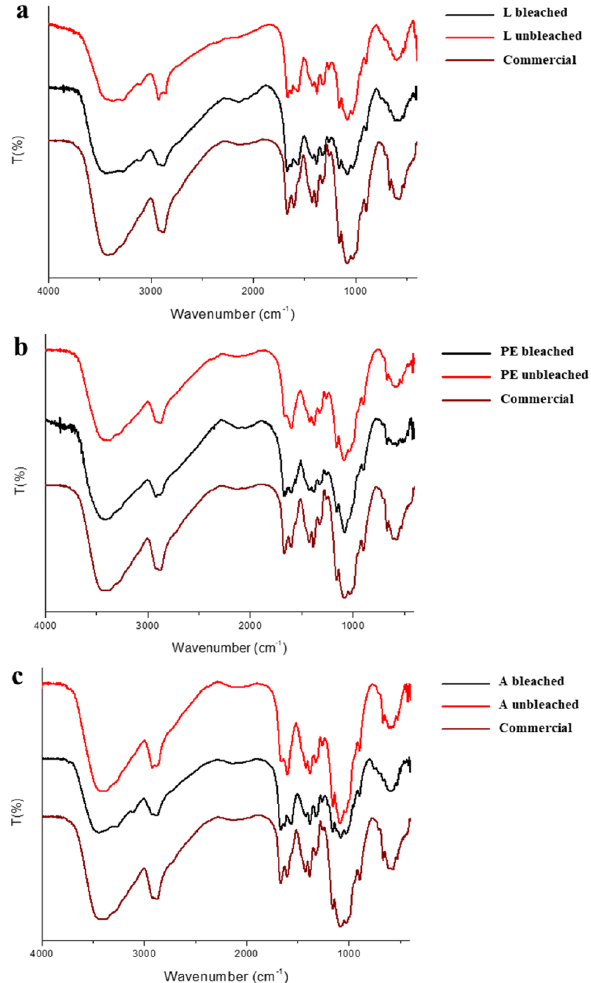
Figure 2. FTIR spectra of bleached (black line) and unbleached (red line) chitosan samples extracted from H. illucens larvae ( a ), pupal exuviae ( b ) and dead adults ( c ). Commercial chitosan (wine lines) derived from crustaceans are also